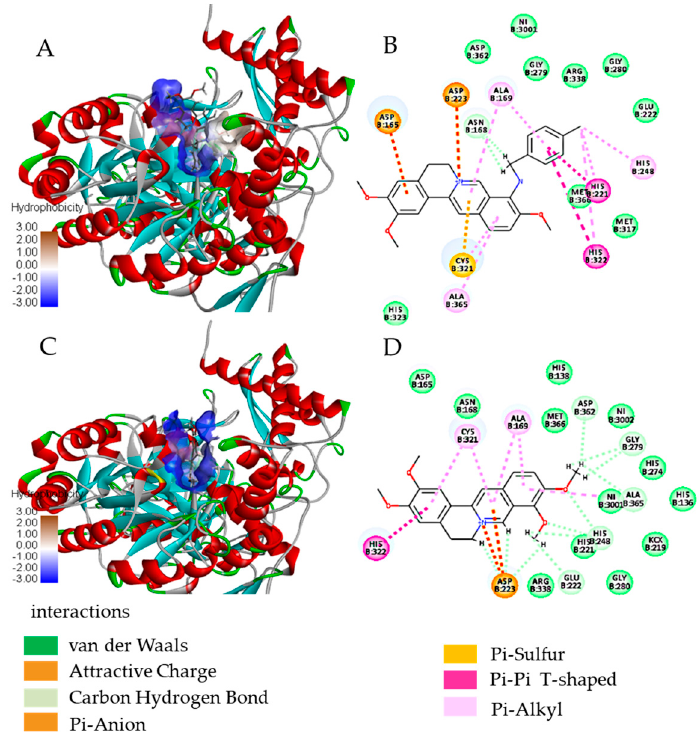
Figure 2. Solid surface maps of the active pocket of H. pylori urease with compound 1c ( A ) and PMT ( C ). Red, blue, and white colored regions correspond to negatively charged, positively charged, and neutral areas, respectively. Binding mode plans of 1c ( B ) and PMT ( D ) within the H. pylori urease active pocket. These figures were produced using the Discovery Studio 4.5 software. Van der Waals force, green; attractive charge force, orange; carbon hydrogen bond force, celadon; Pi-Anion force, orange; Pi-sulfur force, yellow; Pi-Pi T-shaped force, amaranth; Pi-alkyl force, mauve pink. The receptor structure is shown in surface form.